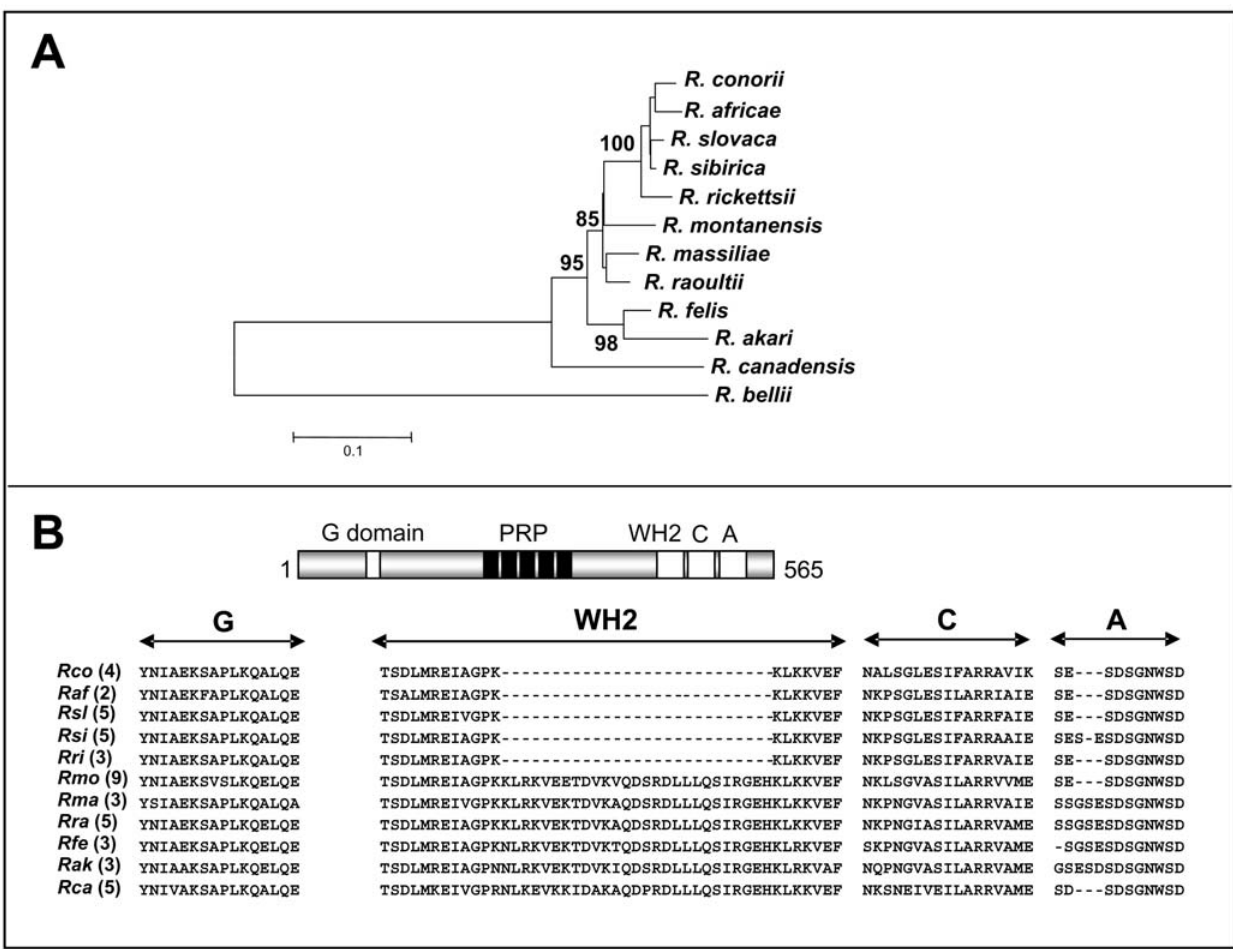
Figure 1. (A) Phylogenetic tree of the bacteria belonging to the genus Rickettsia , inferred from a comparison of RickA protein sequences. This phylogenetic tree was constructed with the NJ method, and using the following RickA protein sequences: R. conorii (rco_ORF0822), R. rickettsii (gi|157828764|), R. slovaca (RISLO1054), R. africae (raf_ORF0824) R. sibirica (ZP00142939), R. massiliae (gi|157844512|), R. felis (gi|67458763|), R. akari (gi|157825980|), R. canadensis (gi|157803553|), R. bellii (gi|91205670|), R. montanensis (gi|75487919|) and R. raoultii (this study). Bootstrap values are indicated at branch nodes. (B) Schematic representation and multiple sequence alignment of the rickettsial RickA proteins from the SFG rickettsiae. G: G-actin binding site. WH2, C and A: WASP-homology 2, central and acidic domains of the WASP-family protein. The numbers of proline-rich repeats (PRR) are indicated in parentheses. Abbrevations are as follows: Rco ( R. conorii ), Raf ( R. africae ), Rsl ( R. slovaca ), Rsi ( R. sibirica ), Rri ( R. rickettsii ), Rmo ( R. montanensis ), Rma ( R. massiliae ), Rra ( R. raoultii ), Rfe ( R. felis ), Rak ( R. akari ) and Rca ( R. canadensis